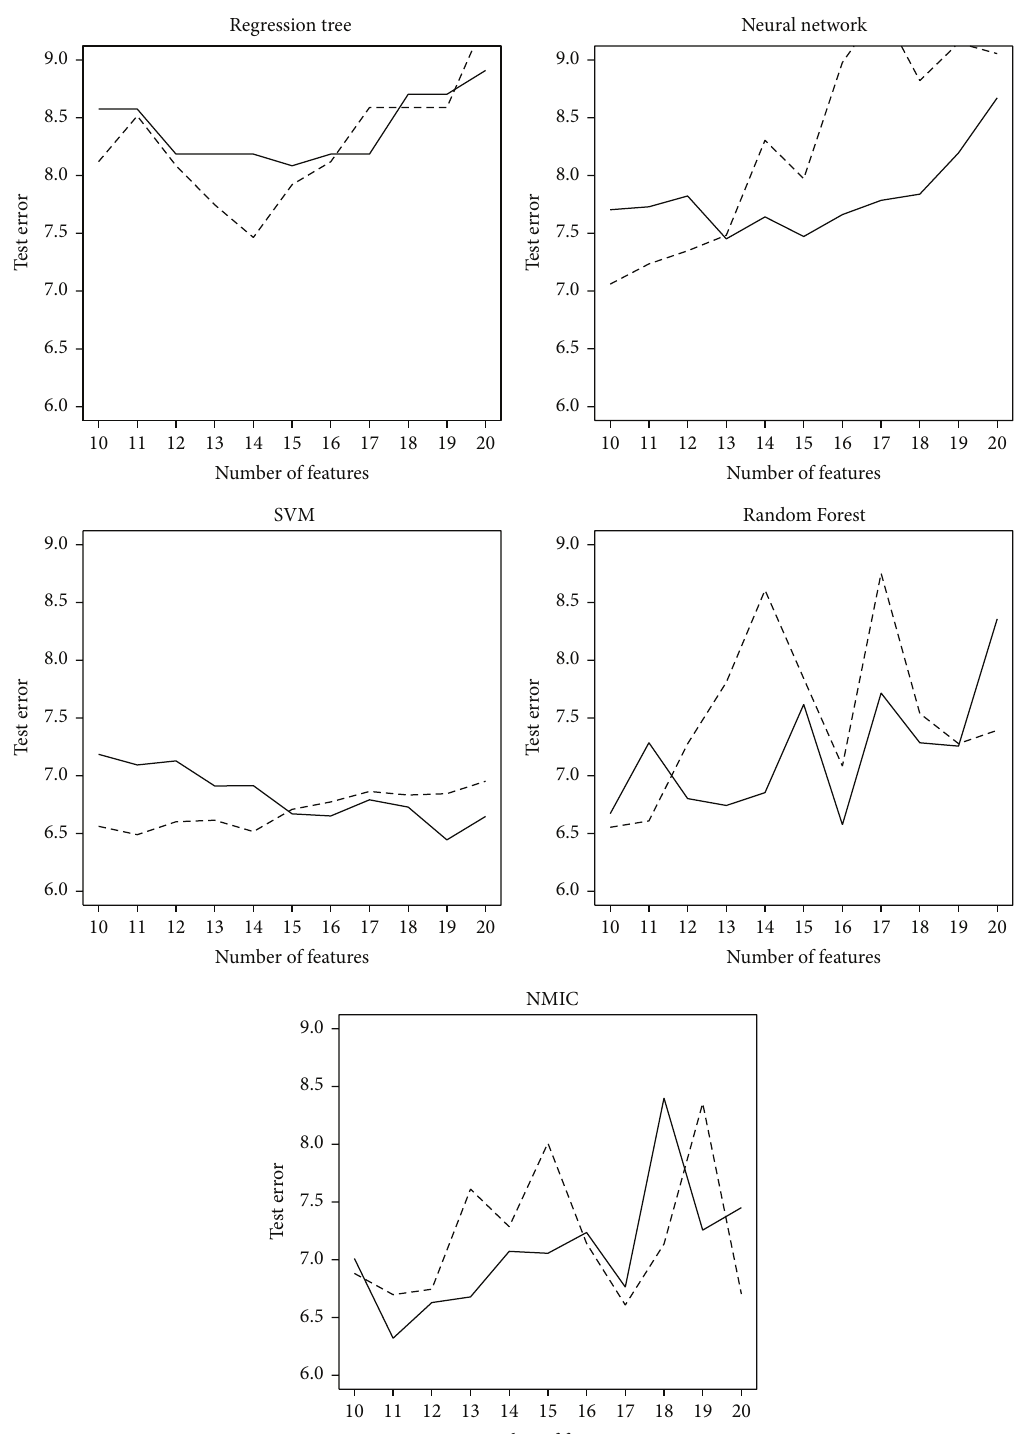
Figure 3: Test errors for feature subsets of sizes 10 to 20. The results associated to a random forest feature importance-based selection, applied to the centerpoints of the fuzzy data, are drawn with dashed lines. The extension of this method to fuzzy data, followed by a learning with the same centerpoints for Regression Trees, Neural Networks, Support Vector Machines, and Random Forest, but the whole fuzzy data for NMIC, are drawn with solid